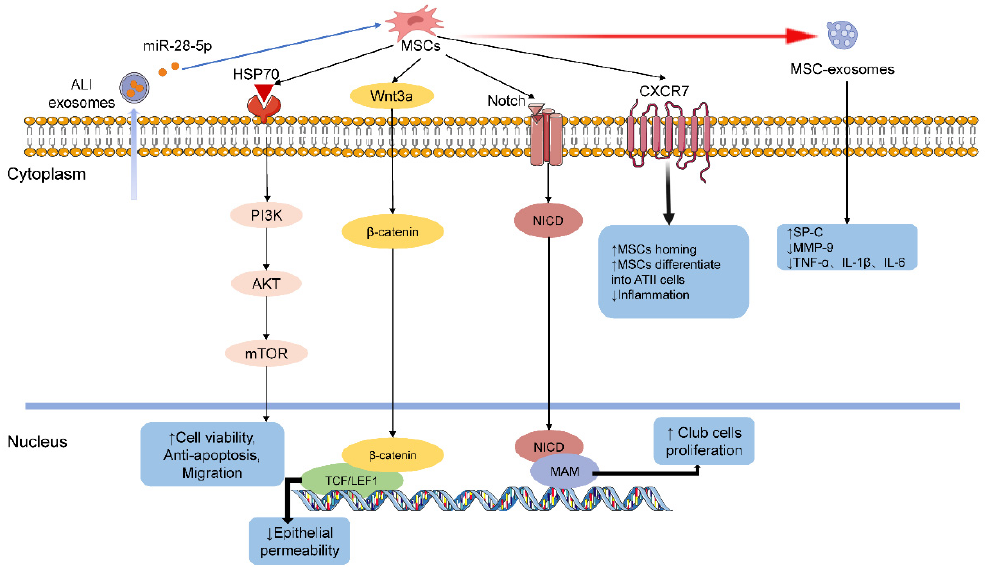
Figure 2. The function of MSCs in P-ALI.